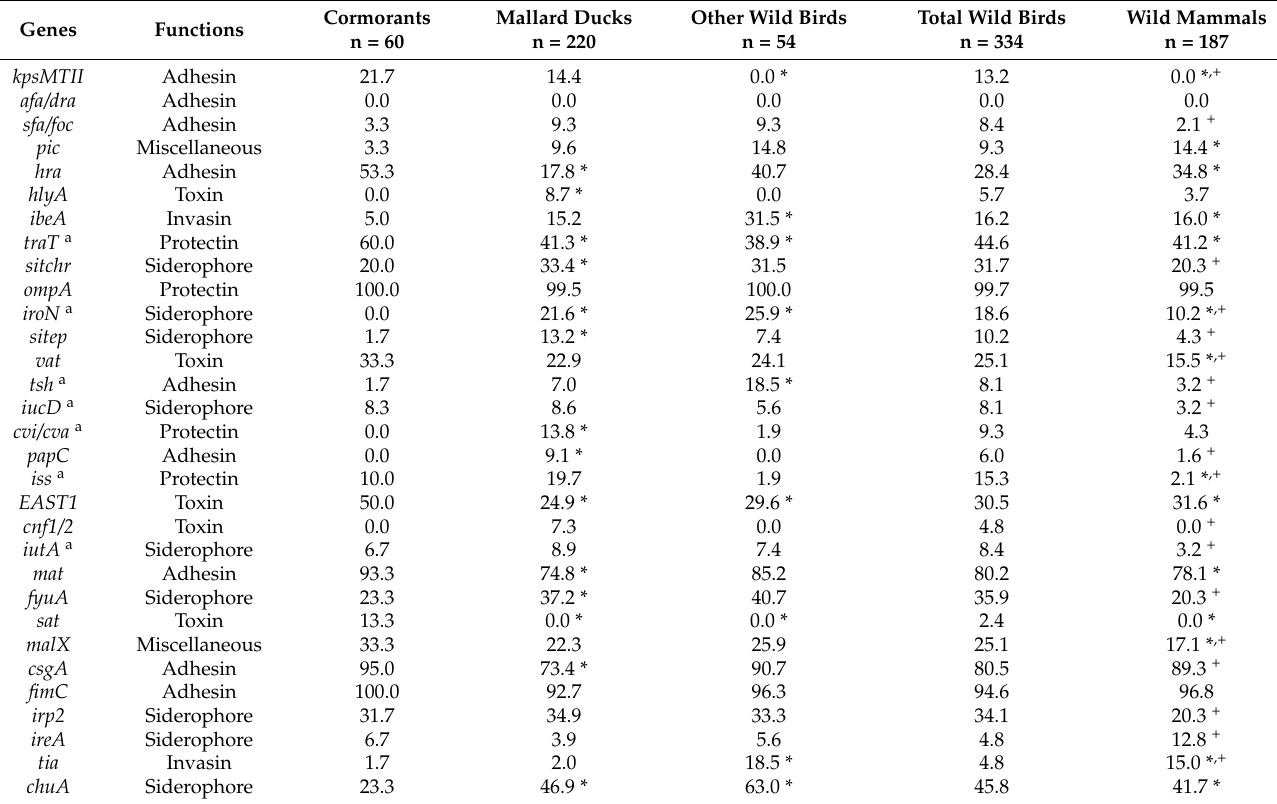
Table 2. Functions and prevalence percentage of detected extraintestinal virulence-associated genes (exVAGs) in E. coli in cormorants, mallard ducks, wild birds, and wild animals. Pearson’s Chi-squared test for count data calculated to compare the significant differences in